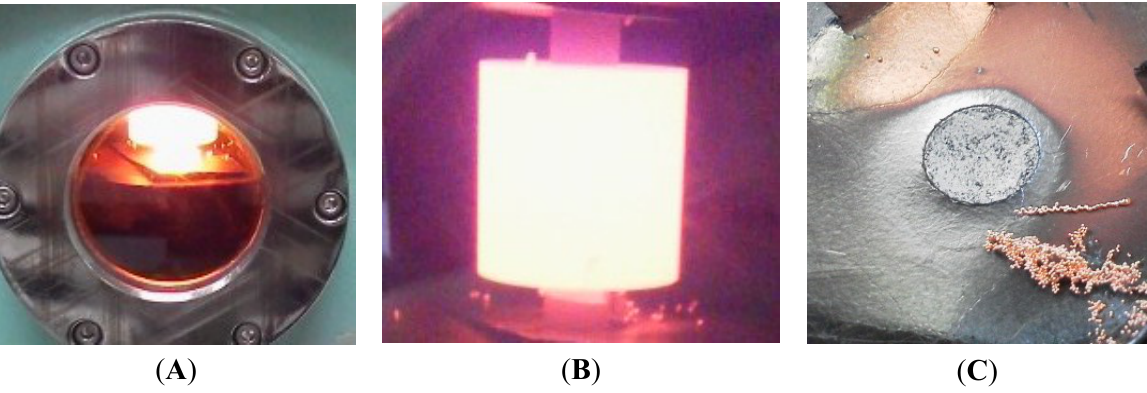
Figure 2. The evidences of Cu evaporated from the die in the Spark Plasma Sintering (SPS) process: ( A ) drops coming out from the graphite die visible through the window in SPS device; ( B ) full image of the SPS graphite die with Cu drops on the graphite punches and Cu vaporized on the graphite foil; ( C ) graphite foil after experiment with Cu deposited from the fume (shown in white dashed lines) and “chains” made of Cu drops (indicated with white